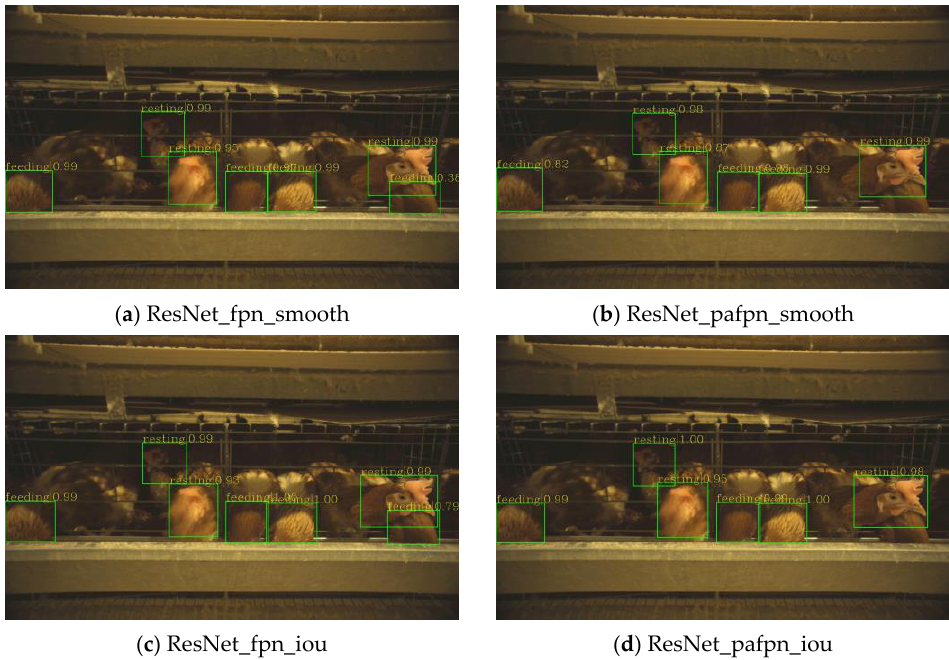
Figure 5. Detection results of different